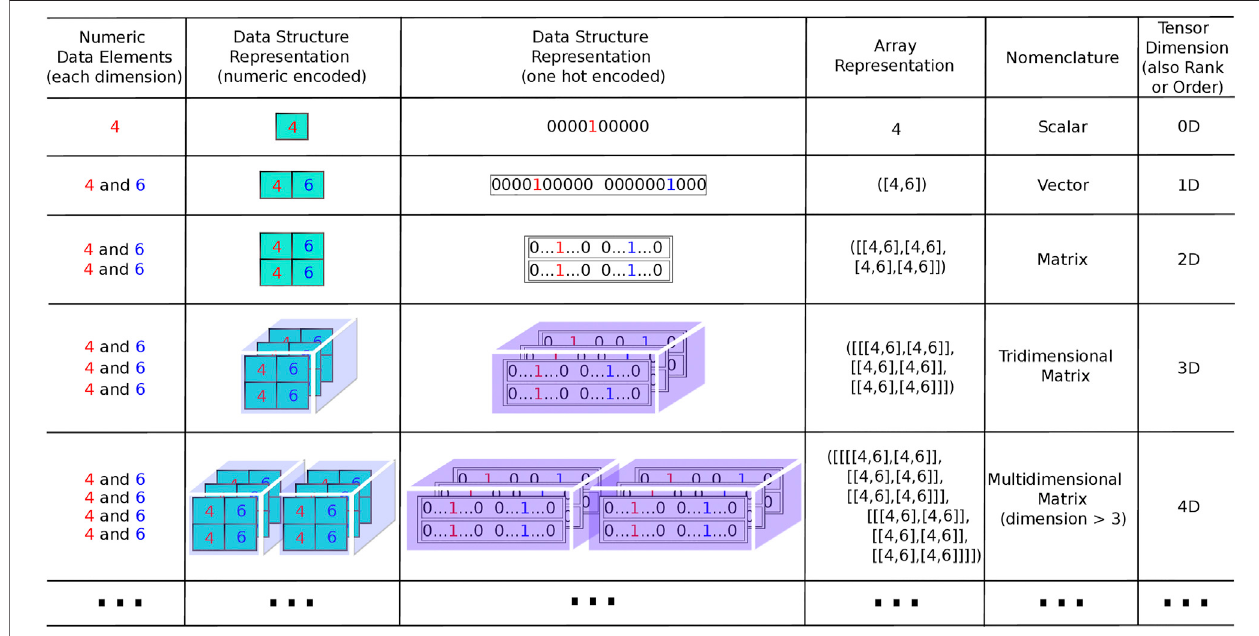
FIGURE1| Representations oftensorsin different orders(dimension, rank).Column 1lists theelementsthatcompose thesets correspondingtoeach dimension. The number of sets is in agreement with the number of dimensions except for the dimension 0, where one set is used as in dimension 1, but comprises a unitary set, as one elementonly isused torepresenta scalar. More elements could have been used ineach set for dimension 1and above, but only two elements were used toreduce the complexity of the fi gure, comprising the same two elements in all dimensions. Column 2 contains elements “ boxed ” and spatially arranged in correspondence with the respective data structure. These comprise a row vector of “ boxes ” for dimension 1, a matrix with rows and columns of “ boxes ” for dimension 2, a block with rows, columns and pages for dimension 3, a row of blocks for dimension 4 and so on. Column 3 exhibits an equivalent arrangement as in the preceding column, except that each element is represented with “ one-hot ” encoding instead of numeric encoding. The “ one-hot ” representation is usual in neural networks to input information representingasetoffeatures.Eachfeatureisrepresentedbya fi nitesetofpossiblevaluesofaspeci fi cfeatureattribute,withvaluesorderedaspositionsinasequenceof values “ 0 ” and “ 1. ” Asanexample,ifaspeci fi cfeaturehasanattributesummarizedashavingNpossiblevalues,itisrepresentedbyasequencewhereonenumericvalue “ 1 ” is located in correspondence with the observed value of the attribute and N-1 values “ 0 ” are located in the positions corresponding to the other values. The input vector for a neural network is, thus, composed by a longer sequence chaining the “ one-hot ” representation of all features. Column 4 of the table presents examples of tensor representations as they are usually coded in computational language (Python coding, for example). At the beginning and ending of the data representation, the number of square brackets must conform to the tensor dimension. Columns 5 and 6 are the nomenclature of each kind of tensors up to rank 4 and its respective